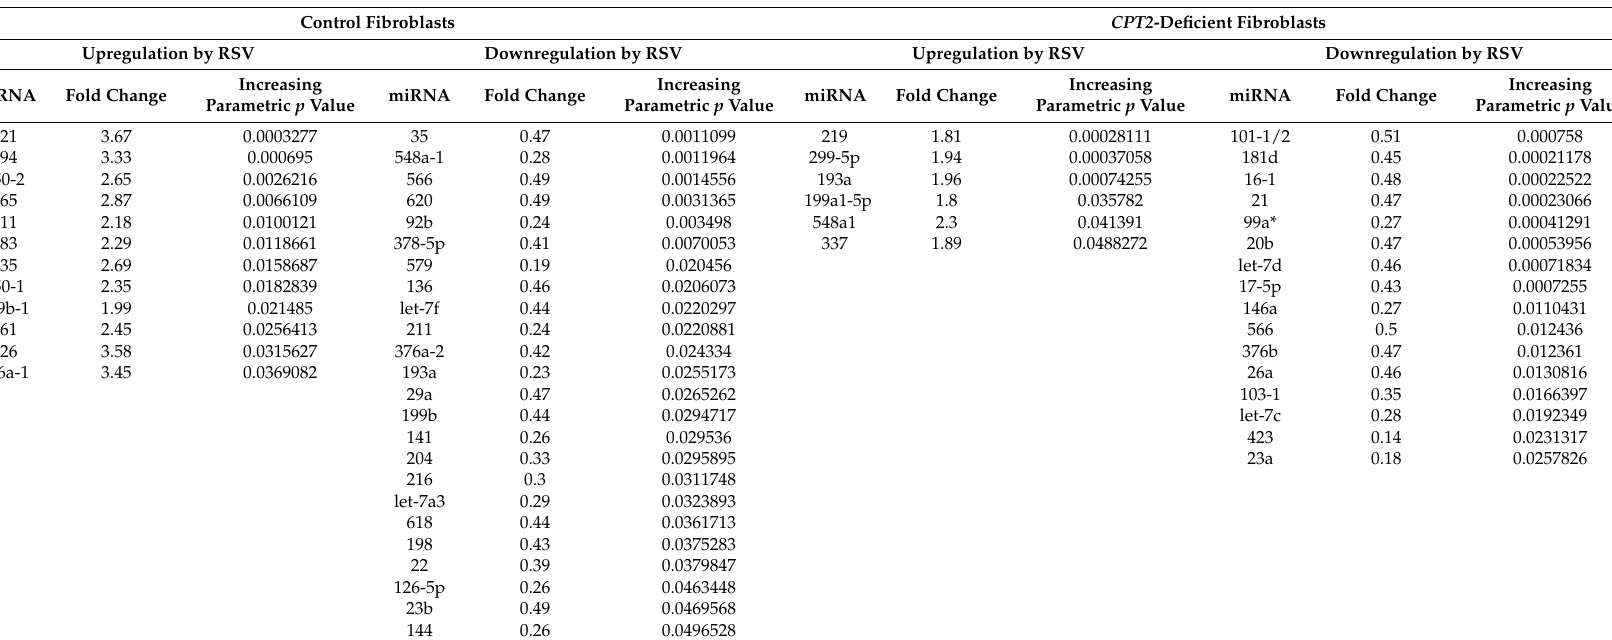
Table 2. RSV (75 µ M) treatment impacts miRNA expression in control and in CPT2 -deficient fibroblasts, compared with the corresponding DMSO-treated primary fibroblasts, as deduced from microRNA microarray analysis. Geometric mean of intensities <100 were considered as background and discarded. Changes were considered significant when p <